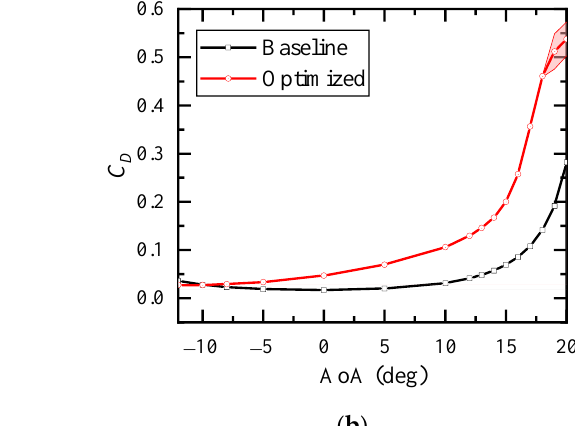
Figure 2. Profile of the baseline and optimized airfoil.